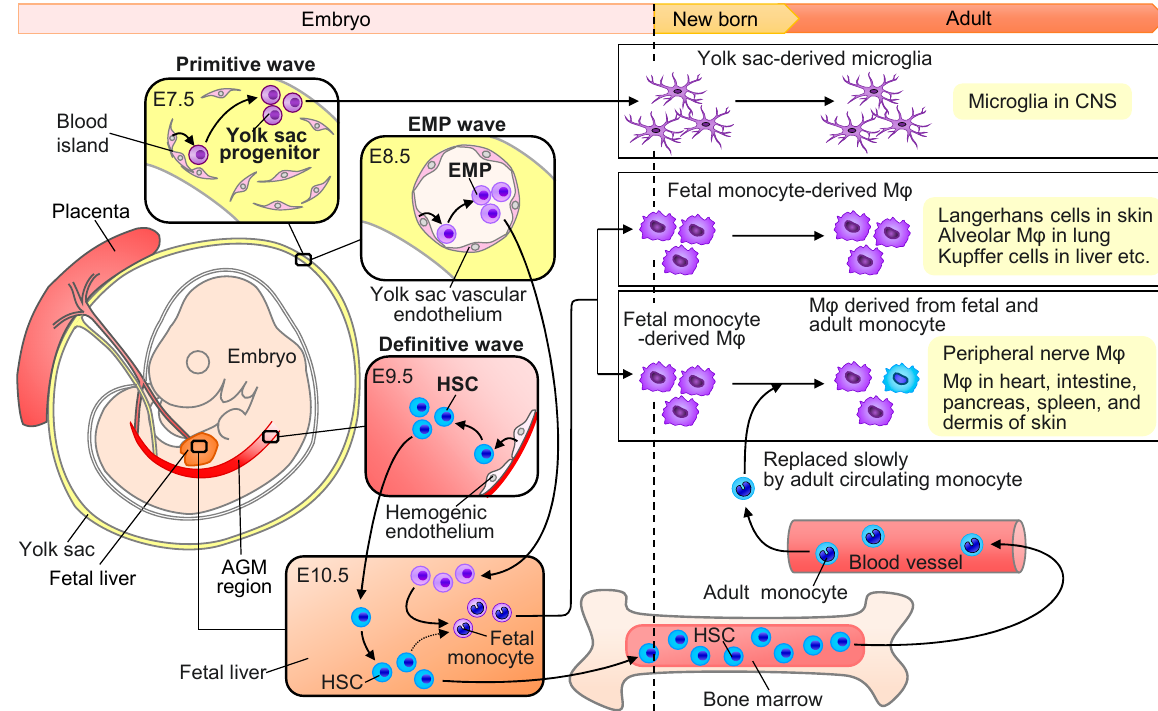
Figure 1. Tissue-resident macrophage (M φ ) generation through three main waves of hematopoiesis during development in mice. “Primitive wave” arises from the blood islands of the extra-embryonic yolk sac at E7.5, and produces primitive yolk sac progenitors, leading to adult microglia in the central nervous system (CNS). The “Erythro-myeloid progenitor (EMP)” wave arises from the hemogenic endothelium formed at E8.5 in the yolk sac and produces EMPs, which migrate into the fetal liver, expand and differentiate into fetal monocytes, leading to adult tissue-resident macrophages in every tissue other than CNS. The “Definitive wave” arises from the intraembryonic hemogenic endothelium of the aorta-gonad-mesonephros (AGM) region, and produces fetal hematopoietic stem cells (HSCs) at E9.5, which colonize the fetal liver and seed the fetal bone marrow, leading to adult HSCs. Some of fetal HSCs might differentiate to fetal monocytes in the fetal liver. The peripheral tissue-resident macrophages proliferate and self-maintain. The fetal monocyte-derived epidermal Langerhans cells, hepatic Kupffer cells, and alveolar macrophages locally self-maintain throughout adulthood, while other tissue-resident macrophages derived from fetal monocytes are replaced slowly by adult-circulating monocyte-derived macrophages.